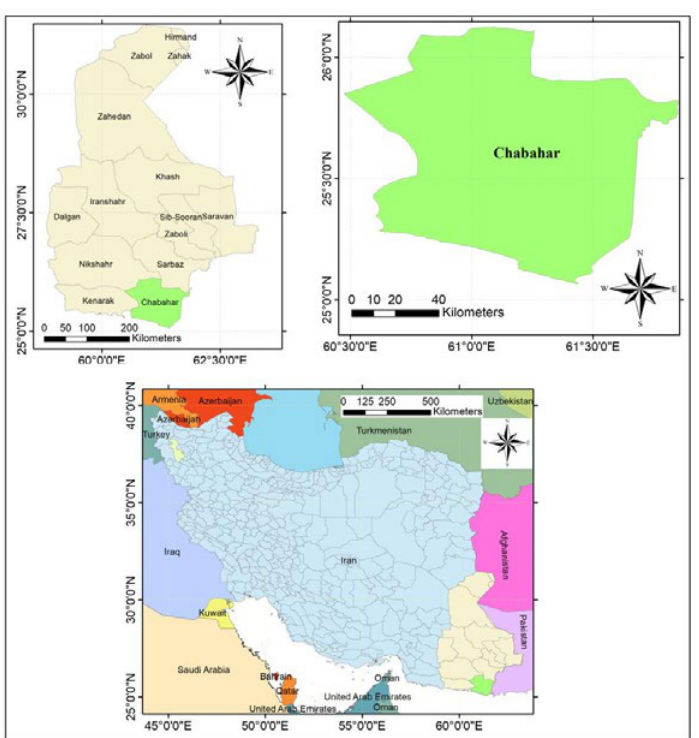
Fig.5. Geographic location of the study area in Chabahar City, Fig.5: Geographic location of the study area in Chabahar City, Iran